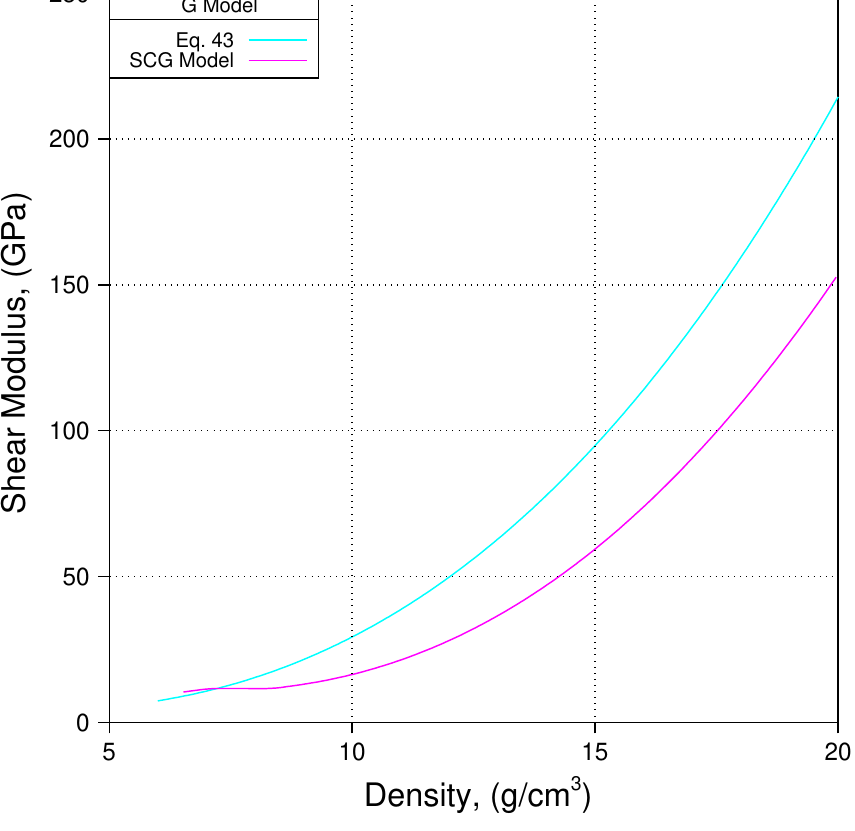
Figure 5. Shear modulus as a function of